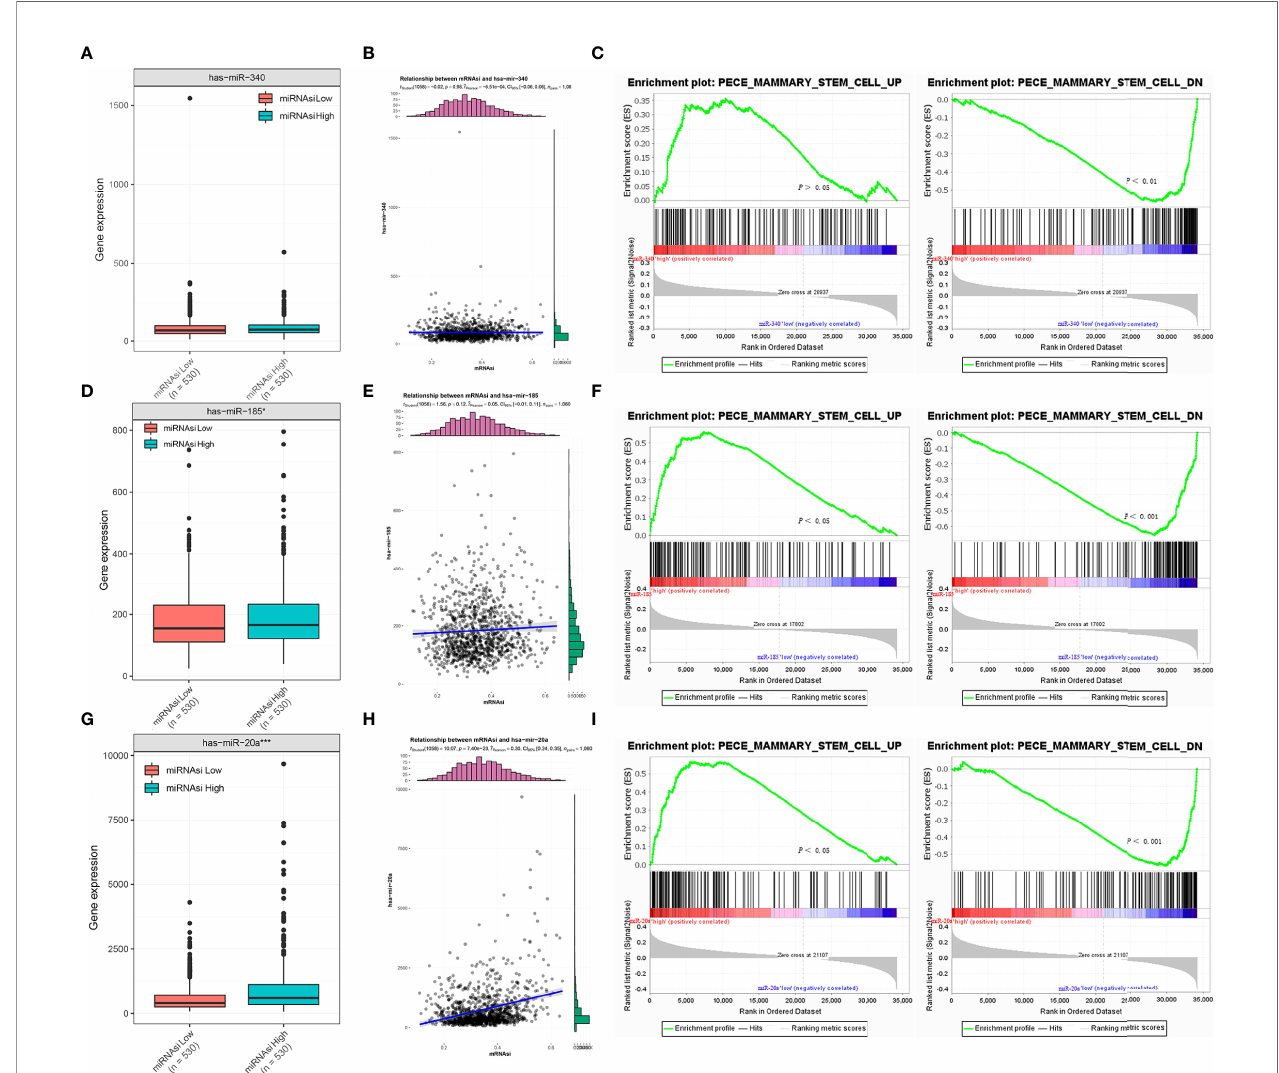
FIGURE 4 | Correlation analysis between miR-340, miR-185, and miR-20a and stemness signature of breast cancer. (A, D, G) TCGA database analysis of miR- 340, miR-185 and miR-20a expression differences in BC mRNAsi high and low groups. (B, E, H) Association analysis between miR-340, miR-185 and miR-20a expression and mRNAsi in BC. (C, F, I) GSEA assessment of the enrichment score pro fi le of miR-340, miR-185, and miR-20a expression in the stemness high and low groups. * P < 0.05; *** P <